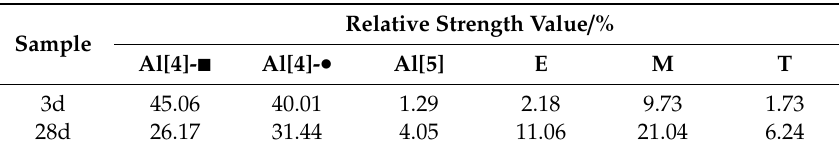
Table 1. Calculation results of deconvolution of 27 Al NMR spectra.